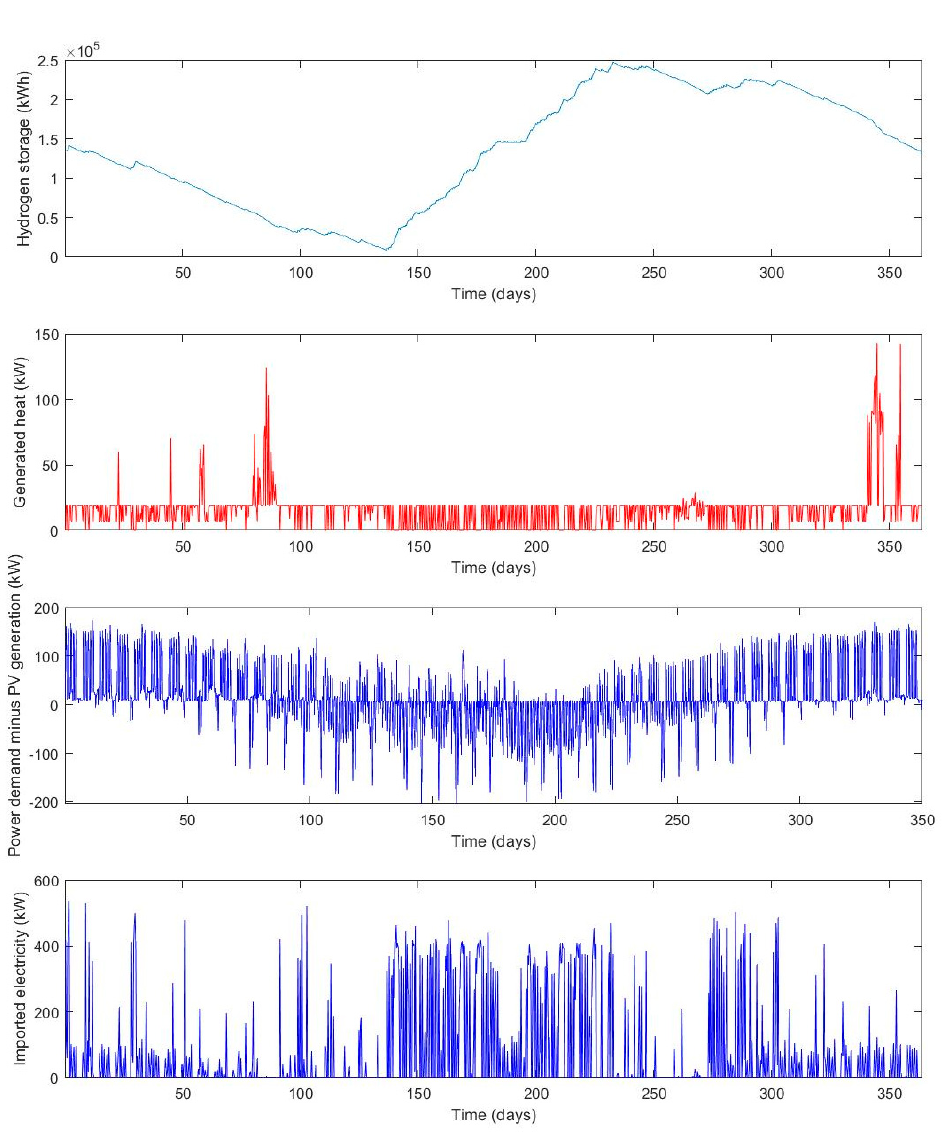
Figure A8. Optimal operation of a 100 / 400 kW RSOC system with 2000 m 2 solar PV panel.